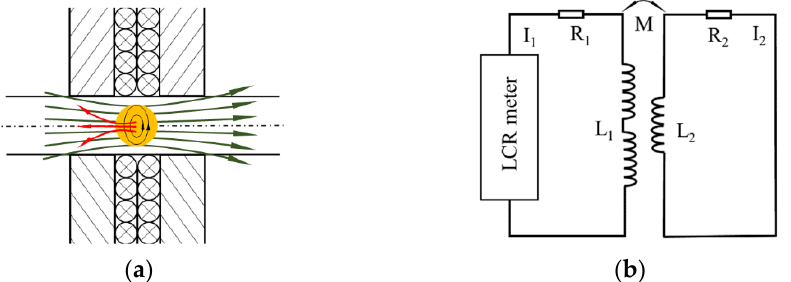
Figure 3. Eddy current effect of ( a ) eddy current coupling model of metal particles and coils, ( b ) eddy current detection equivalent circuit.